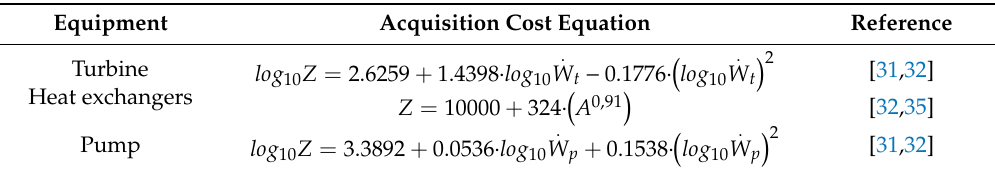
Table 2. Cost equations for equipment